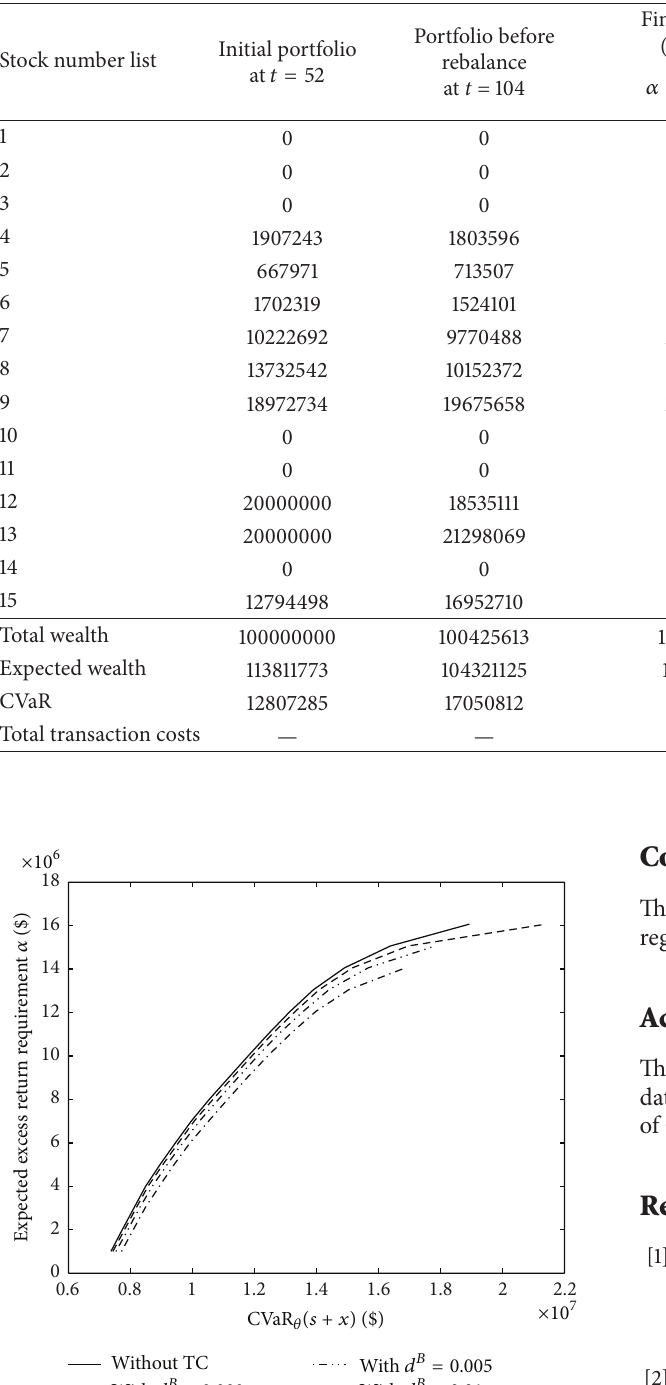
Table 1: Results for initial portfolio and final portfolio (unit: $).